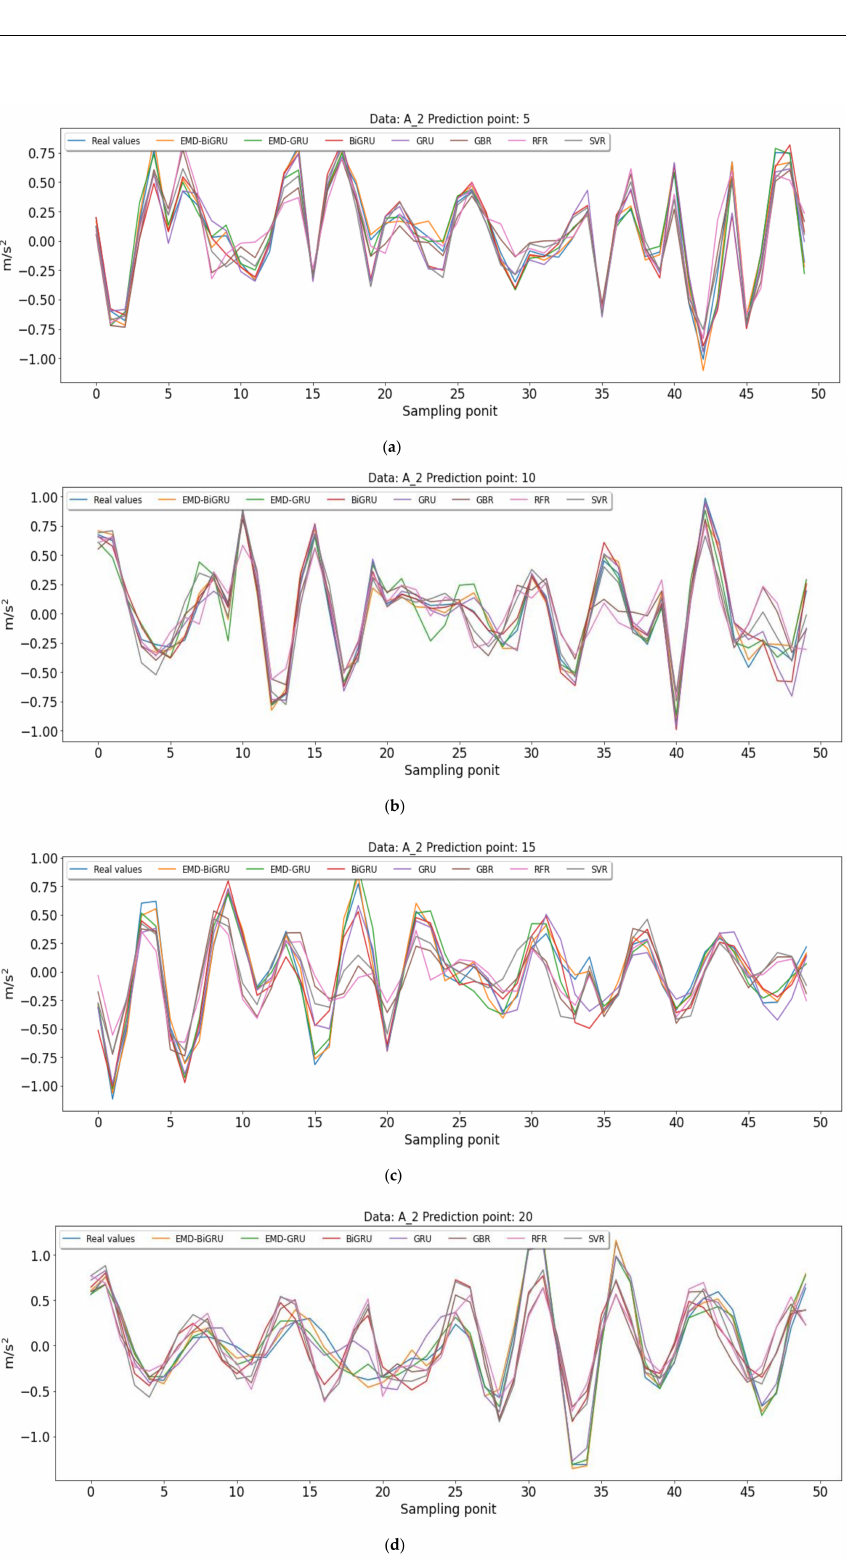
Figure A1. Comparisons results for different data sets using various algorithms. ( a ) Comparisons of predicted results for the A_2 data set using different algorithms (points 5). ( b ) Comparisons of predicted results for the A_2 data set using different algorithms (points 10). ( c ) Comparisons of predicted results for the A_2 data set using different algorithms (points 15). ( d ) Comparisons of predicted results for the A_2 data set using different algorithms (points